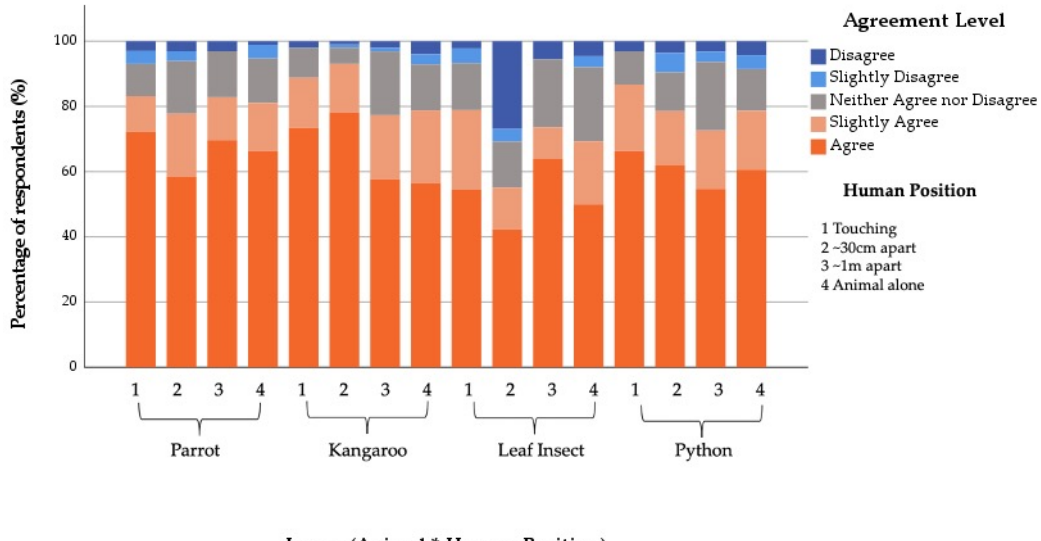
Figure 3. Percentage of General Public respondents’ agreement to the statement “the featured animal is cared for by the zoo” in relation to the allocated images (Featured Animal by Human Position).